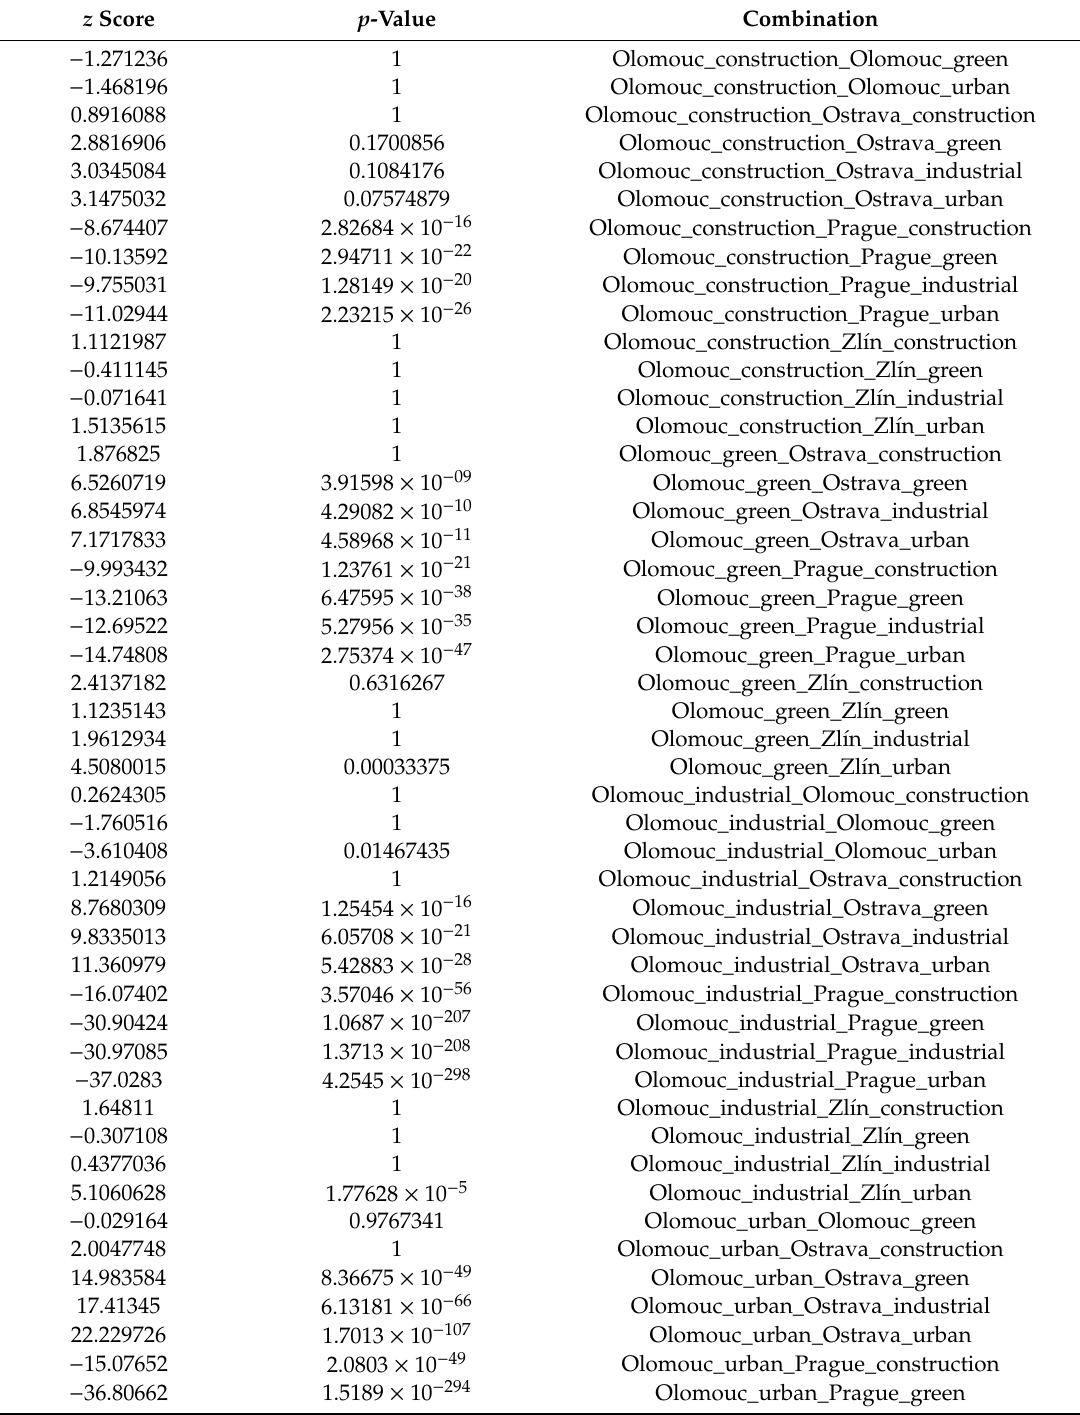
Table A1. Results of the Dunn test: multiple comparison of the combination all land use categories and city a ffi liation. Combinations with a p -value greater than 0.05 cannot reject the null hypothesis that no di ff erence exists between the